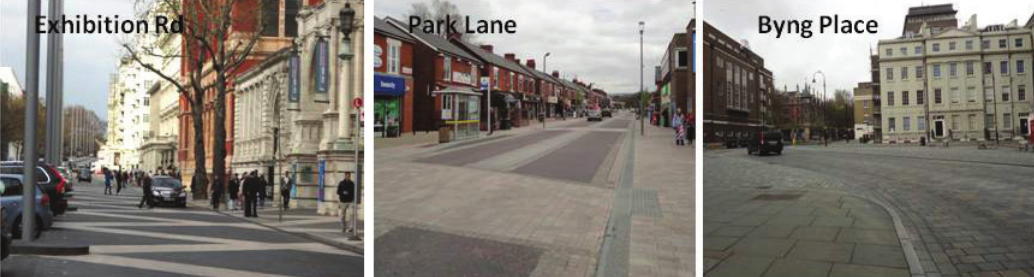
Figure 4. Visual narrowing in case studies